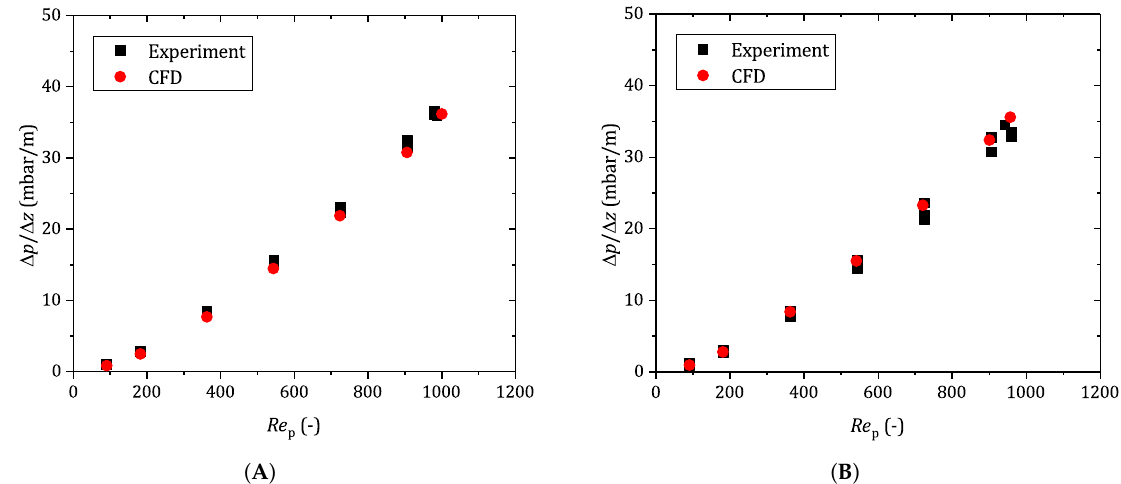
Figure 6. Predicted specific pressure drop in comparison to experimental results for ( A ) the reactor without heat fins, and ( B ) the reactor with helical